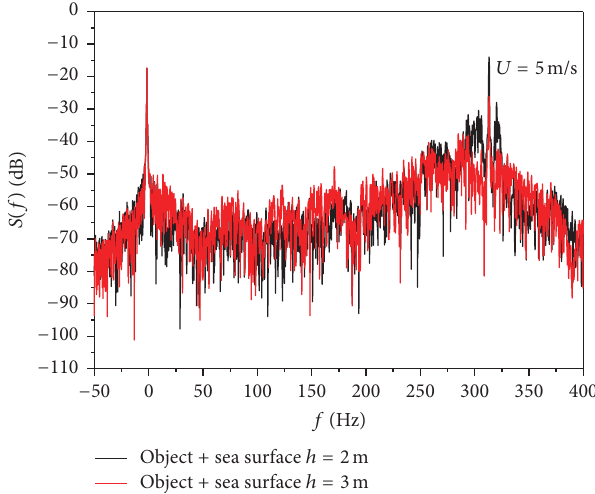
Figure 5: Doppler spectra at different